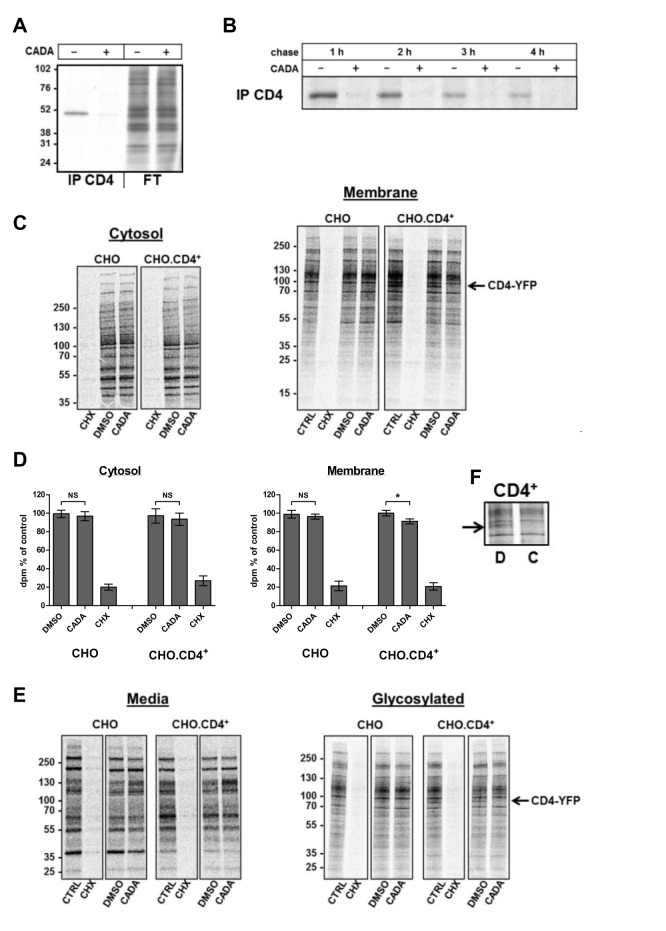
CADA specifically inhibits the biogenesis of human CD4.(A, B) CADA inhibits the biosynthesis of CD4. CD4+.CHO cells were washed and kept in methionine and cysteine-free medium in the presence or absence of 16 µM CADA for 45 min before exposure to [35S]methionine/cysteine (Met/Cys) for 30 min. Pulsed-labelled cells were then washed, lysed, and analyzed directly (A) or incubated in normal medium for up to 4 h (chase) in the presence or absence of 16 µM CADA (B). At specified time points cell lysates were immunoprecipitated for CD4. The flow through fraction (FT) of the CD4-immunoprecipitated samples is also presented. Note that the weaker CD4 bands in the control samples at longer chase time points are the result of the high turnover of hCD4 in CHO cells. Molecular mass is in kDa. (C–F) CD4 negative and stably CD4-YFP transfected CHO cells were pretreated with CADA (5 µM) or DMSO for 1 h before starvation in Met/Cys free medium with CADA, DMSO, or 50 µg/ml CHX. Cells were pulsed for 30 min, washed, and incubated in fresh medium without serum for 90 min. After collection of supernatant proteins (Media) cells were first permeabilized with digitonin buffer to obtain the cytosolic cell fraction before lysis in NP-40 buffer to collect the membrane proteins. Membrane fractions were further incubated with Concanavalin A (ConA) agarose beads (Glycosylated). Molecular mass is in kDa. (D) Quantification of 35S incorporation in (C) by scintillation counting (n = 4). NS, not significant; *p<0.01. (F) ConA fraction from a repeat experiment with CHO.CD4+ cells treated with DMSO or CADA. Note that the expression of CD4-YFP (∼80 kDa) is clearly reduced by CADA-treatment (indicated by arrow).